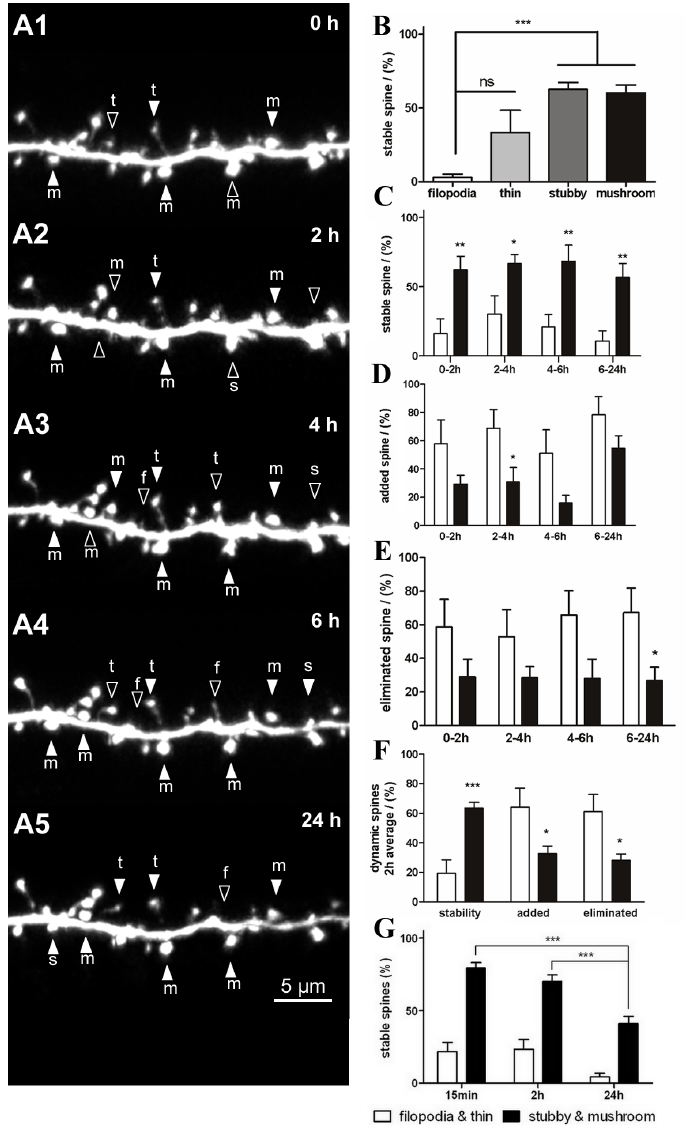
Fig 4. Stability and dynamics of dendritic spines during long-term observation. (A) Serial time-lapse images of a dendritic branch showing stable spines (filled arrowheads) and dynamic spines (open arrowheads) at 2-h intervals. (B) Stability of the 4 types of dendritic spines was observed at 2-h intervals. (C) Detailed analysis of stability of filopodia and thin spines versus stubby and mushroom spines during each 2-h interval observation. (D, E) Detailed analysis of filopodia and thin spines versus stubby and mushroom spines that were added (D) or eliminated (E) during each 2-h interval observation. (F) Average data of dendritic spine stability and dynamics at each 2-h observation. (G) Stability of the dendritic spines at different time interval observations. Bars indicate means ± SEM. N = 4 neurons with 7 dendrites were used for the 2-h and 24-h long-term observations. Significance was set at * P < 0.05, ** P < 0.01, and *** P <